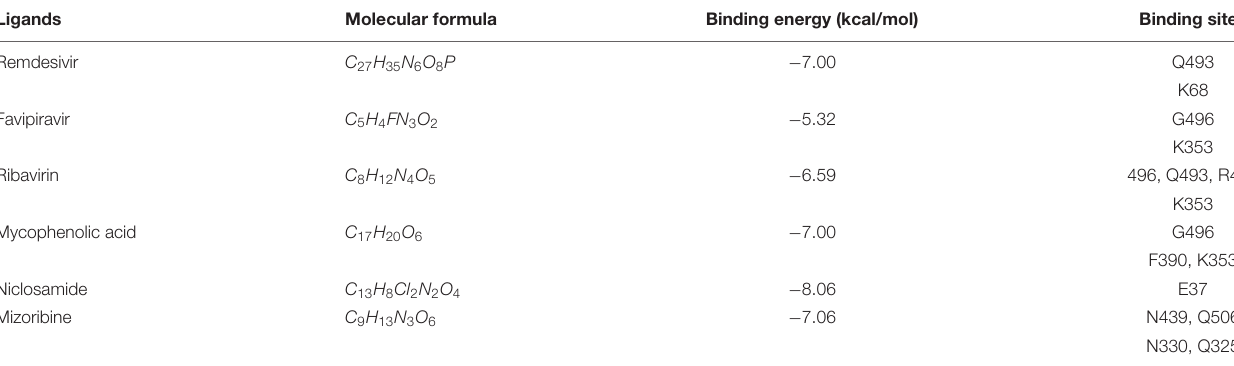
TABLE 8 | Molecular docking between antiviral drugs and the junction of the S protein-ACE2 interface. Ligands Molecular formula Binding energy (kcal/mol) Binding